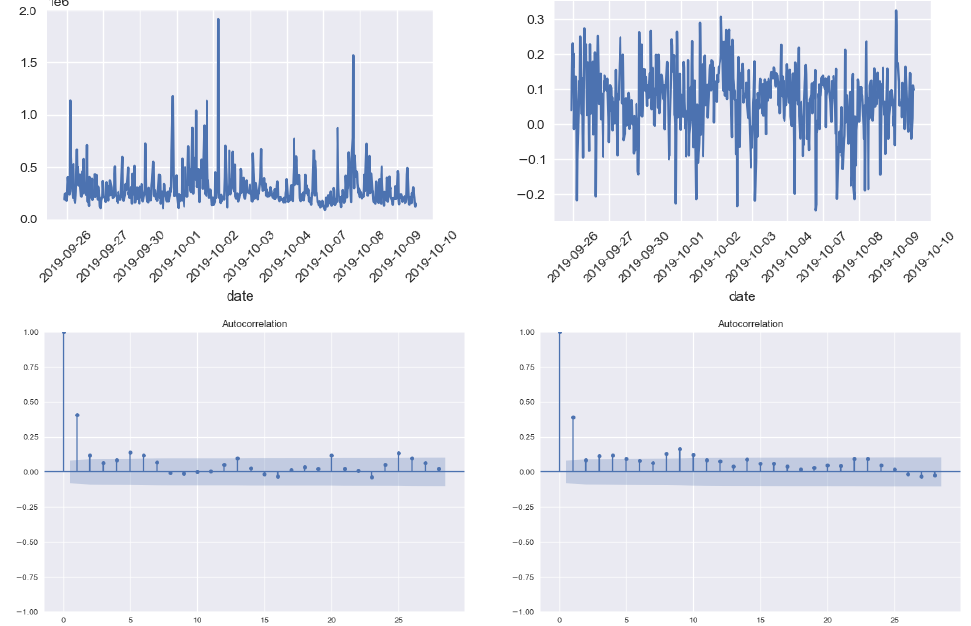
Figure 3. Sentiment and Popularity indexes of Apple ranging from 25 September 2019 to 18 February 2022 ( upper part ) and the corresponding autocorrelation function ( lower part ).